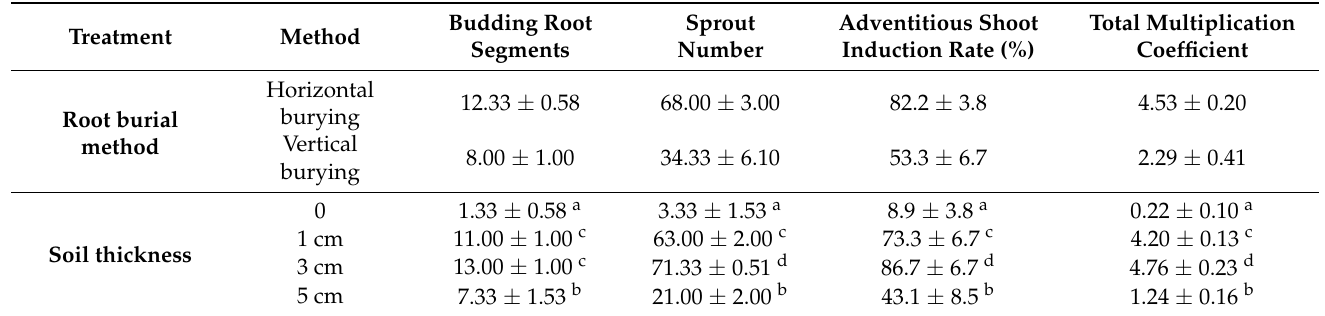
Table 5. Effects of different root burying methods and thickness of covering soil on adventitious shoots induction rate and multiplication coefficient.